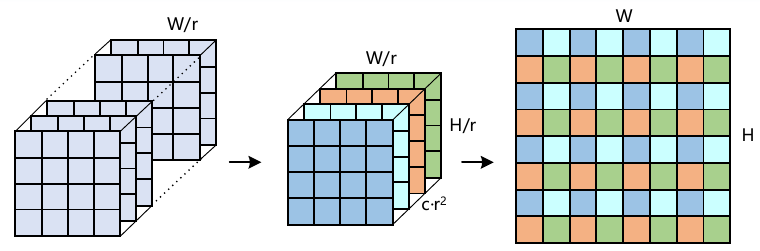
Figure 5. The sub-pixel convolutional operation on the input feature maps with an upscaling factor of r = 2, channel c =